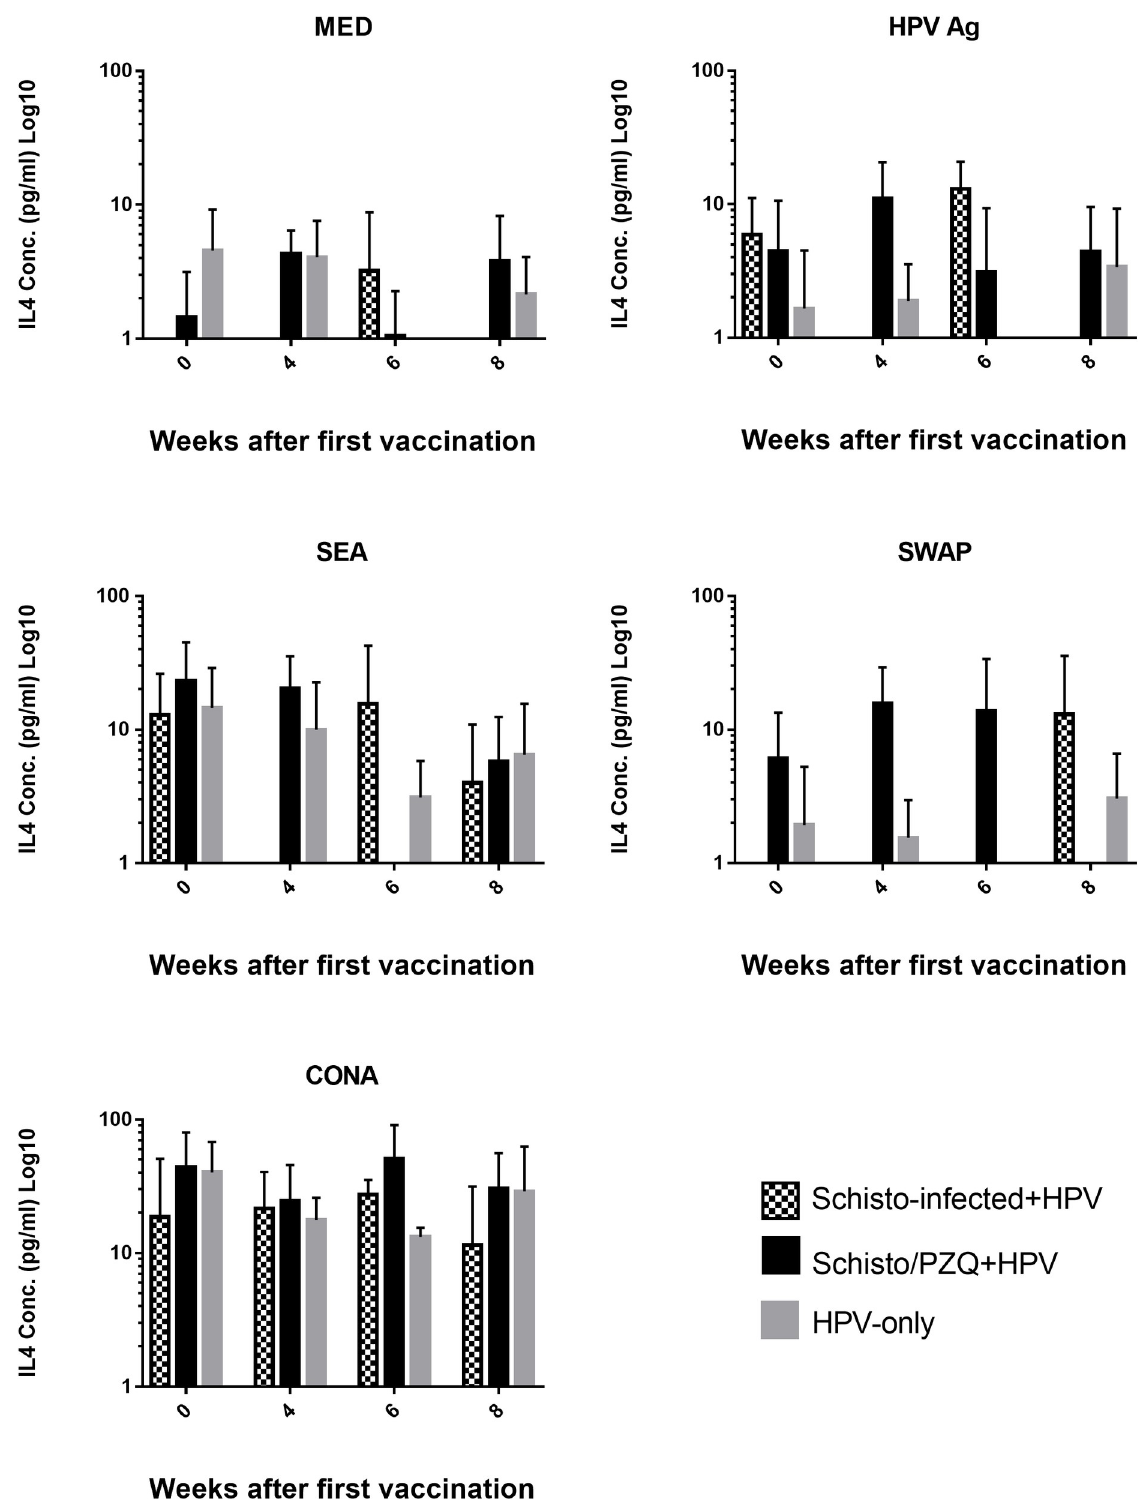
Fig 6. IL-4 cytokine concentrations. Production of IL-4 cytokine in supernatants during Specific (HPV, SEA and SWAP) and non-specific stimulation (CONA) and absence of stimulant (MED) in Schisto-infected+HPV, Schisto/PZQ+HPV vaccine and HPV-only (Control) groups. PBMCs collected from the 3 groups (n = 3) at the 4 time points; Week 0 (pre-vaccination), Week 4 (4 weeks after the 1 st